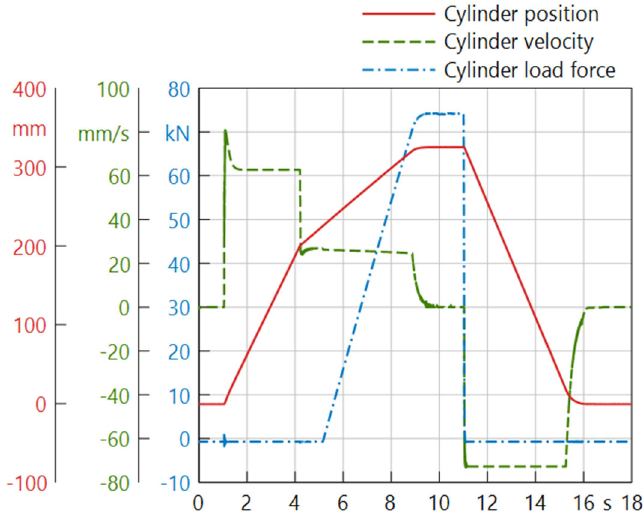
Figure 3. Simulated working cycle of the hydraulic press in regular operation.